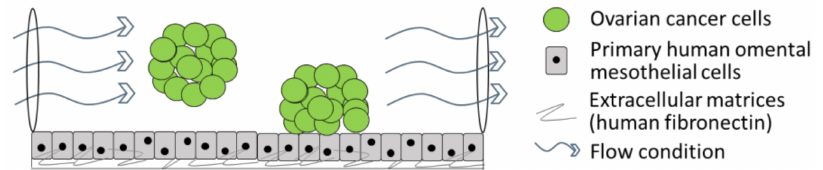
Figure 3. Three-dimensional organotypic model of cancer cells circulating in